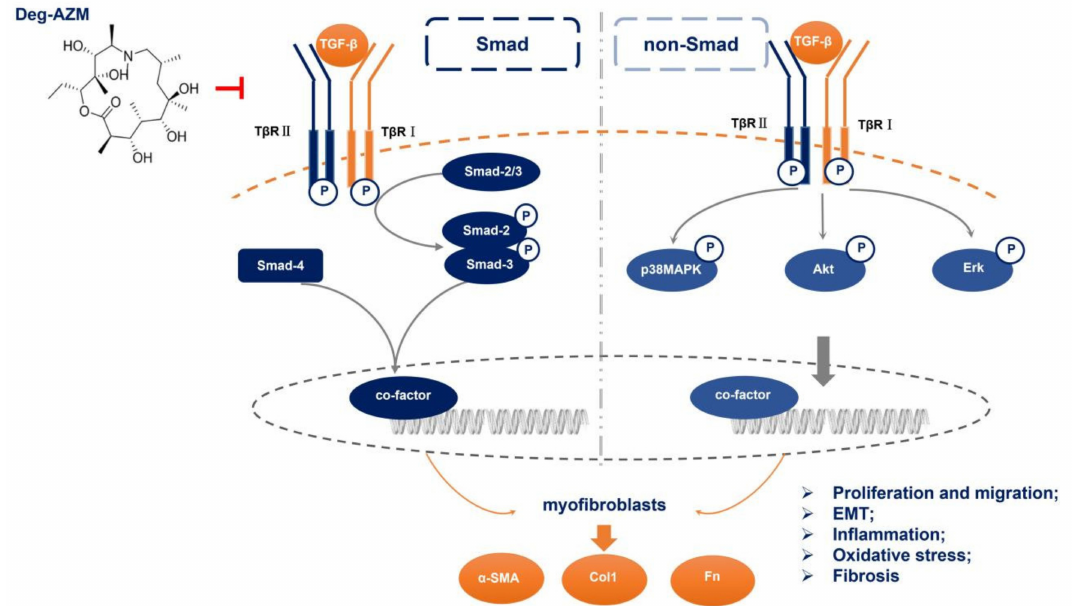
Figure 9. Proposed mechanism for the anti-pulmonary fibrosis effect of Deglycosylated azithromycin. Deglycosylated azithromycin targeting TGF- β 1 downstream Smad3 and MAPK signaling pathway, and then inhibiting fibroblasts activation and EMT process, subsequently ameliorates bleomycin-induced pulmonary fibrosis in